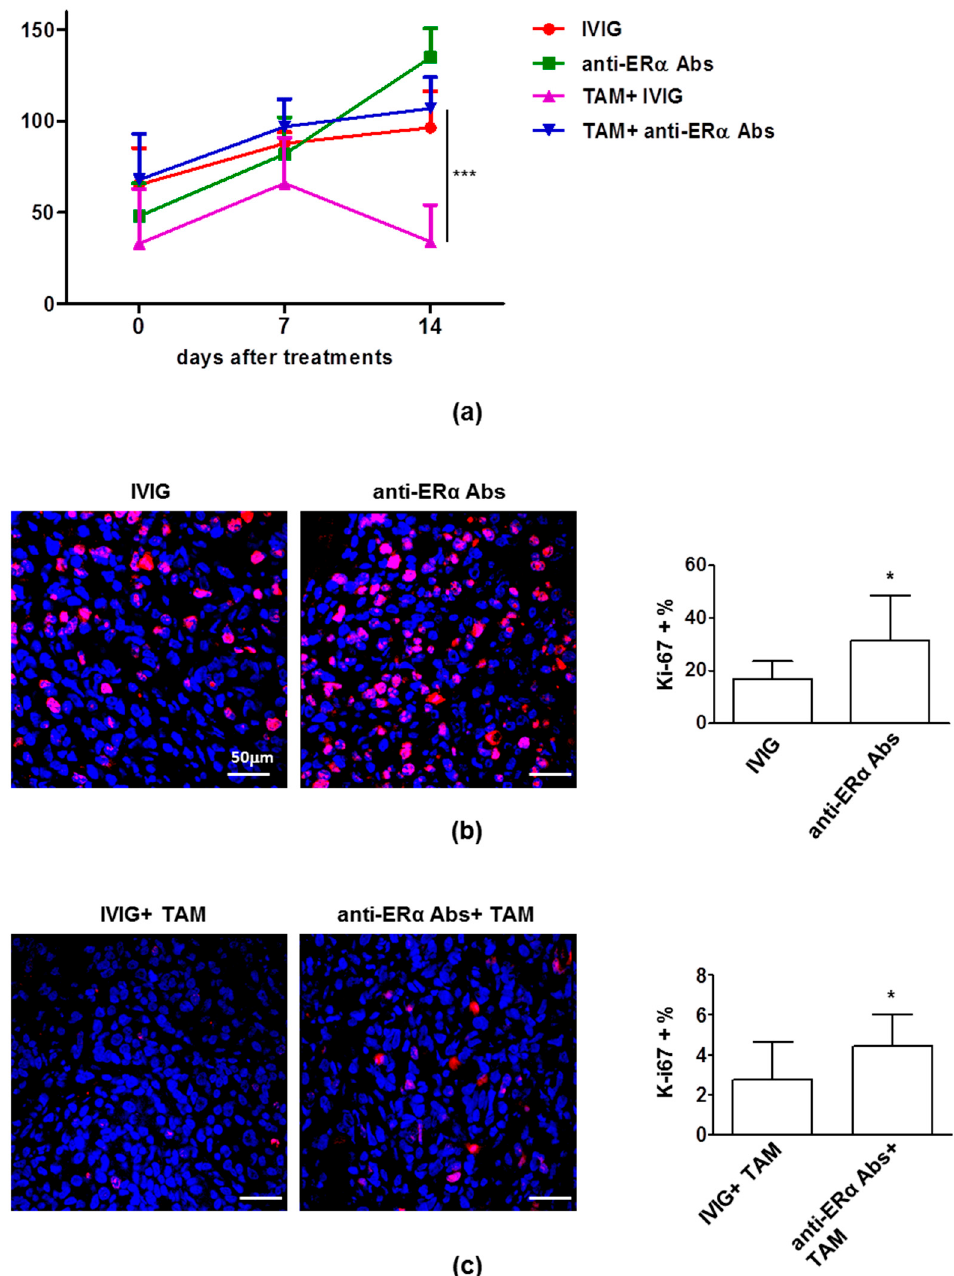
Figure 2. Anti-ER α Abs induced tumor growth and TAM resistance in breast cancer xenografts in Severe Combined Immunodeficiency (SCID) mice. ( a ) The mean ( ± SD) of the tumor volume of one set of experiment (10 mice / group) was shown. The tumor volumes were calculated at day 0, day 7 and day 14 using the following formula: (a × b2) / 2, where a and b represent the longest and shortest diameters, respectively. At day 14, TAM + IVIG vs. TAM + anti-ER α Abs: ***, p < 0.001 by Student’s t test. ( b , c ) Representative sections from MCF-7 tumors treated with IVIG, anti-ER α Abs, TAM + IVIG and TAM + anti-ER α Abs immunostained with anti-Ki67 (red) antibodies and counterstained with Hoechst (blue) are shown. Only nuclear staining (plus mitotic figures) was considered positive. Ki-67 was scored by the average method as reported in Methods. Results are represented as mean ± SD.